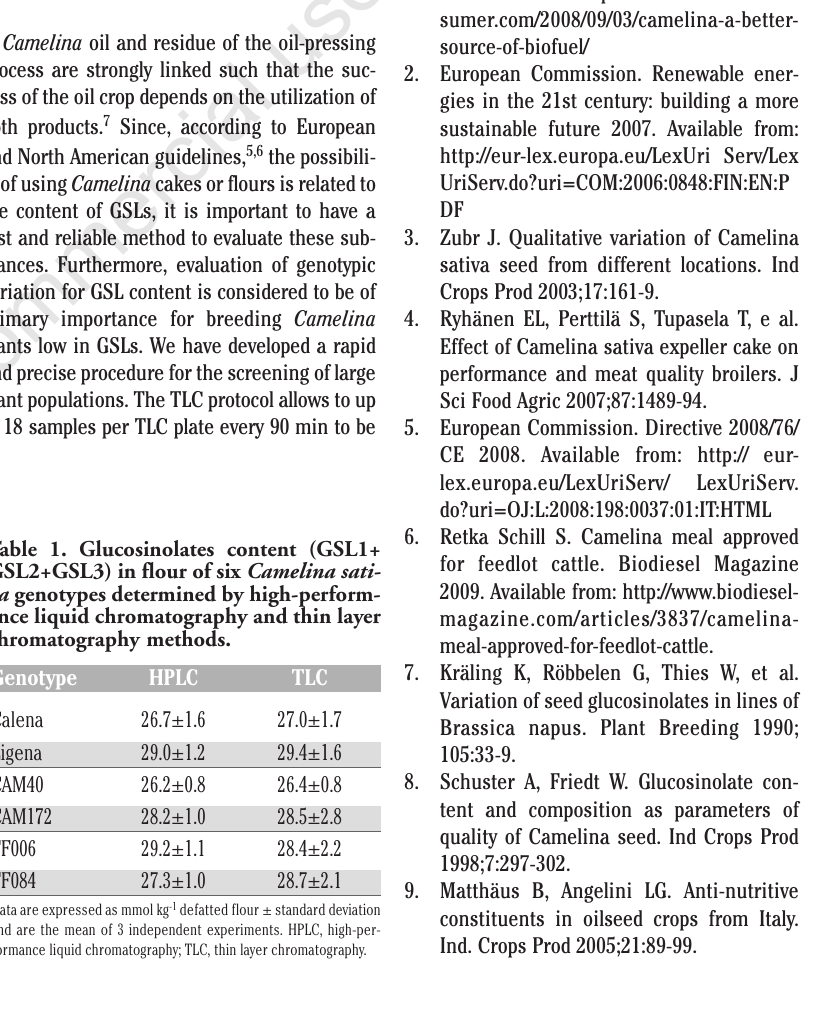
formance liquid chromatography; TLC, thin layer